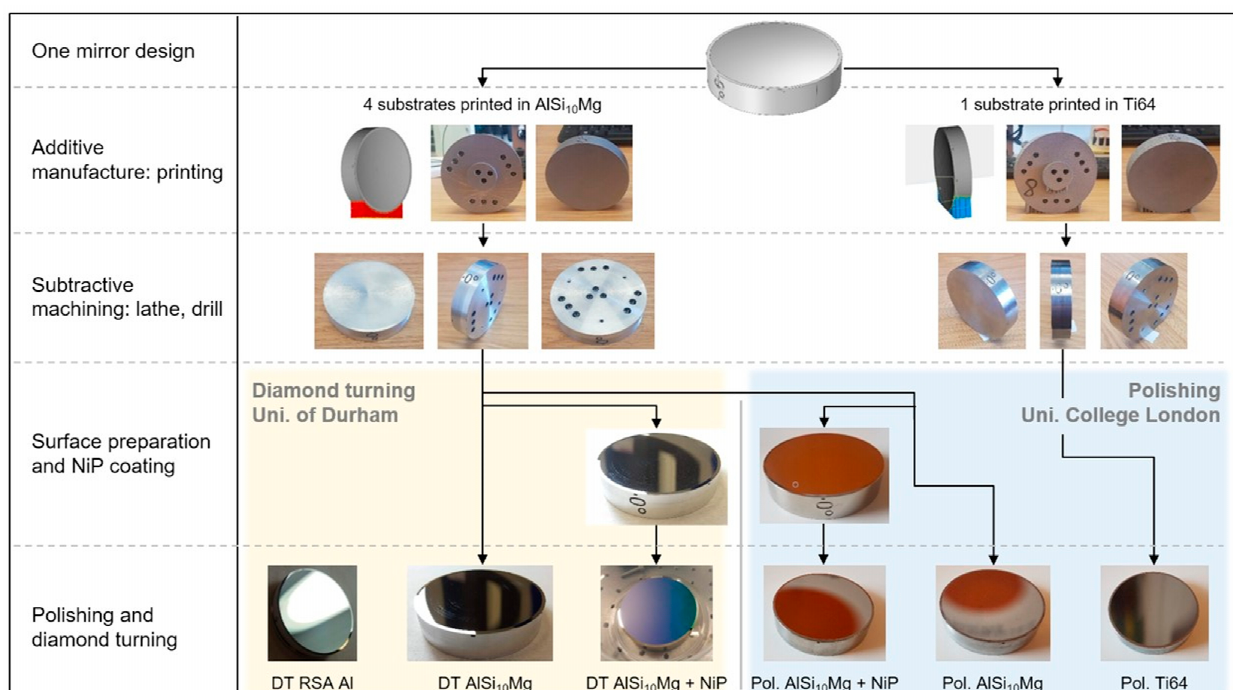
Figure 25. Schematic diagram of several experimental methods [65].